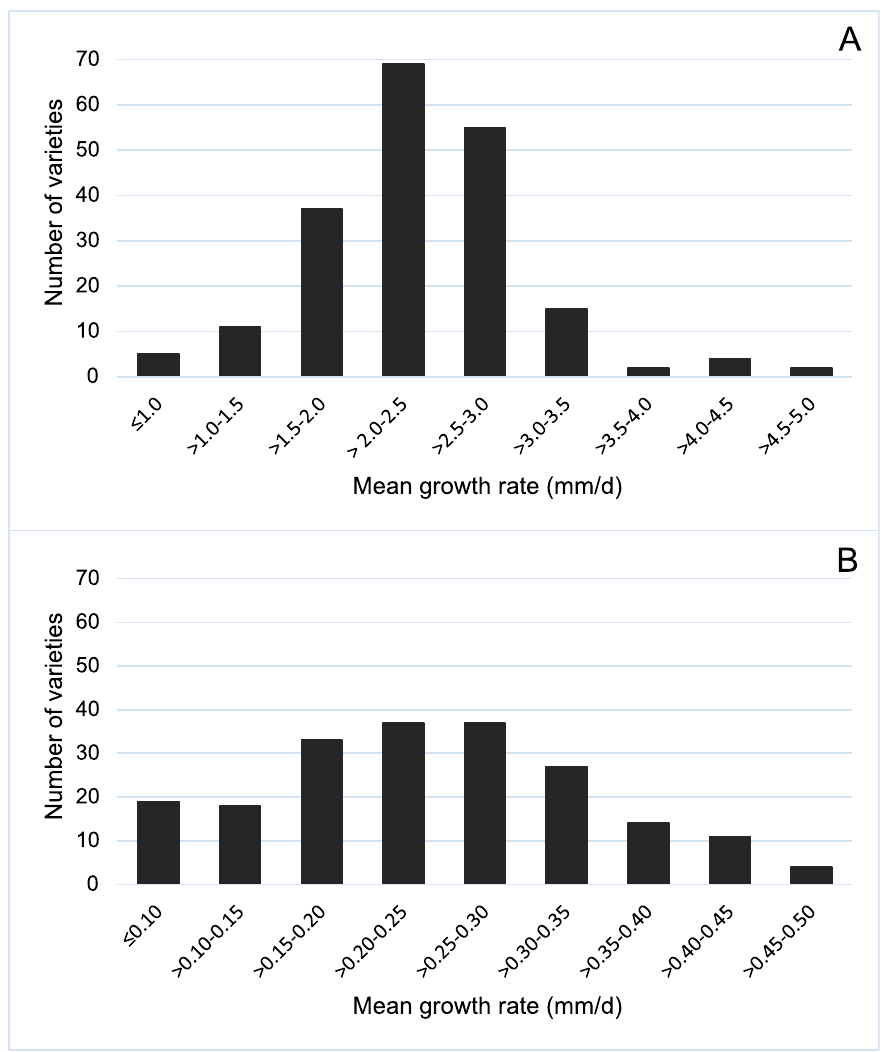
Fig 1. Variability for mean growth rate of coleoptiles (length/number of days) of 200 rice varieties when germinated at 25˚ (V25) until reached 15–20 mm long (A) and at 15˚C (V15) for 21 days (B).